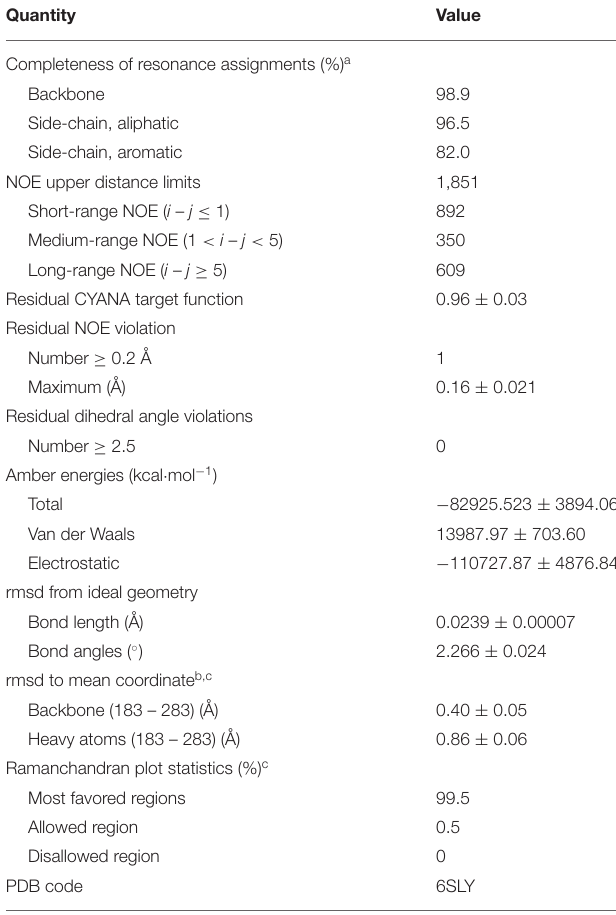
TABLE 1 | Experimental data for the NMR structure calculation and the structural statistics of the 20 energy-minimized conformers of Hp TonB 107